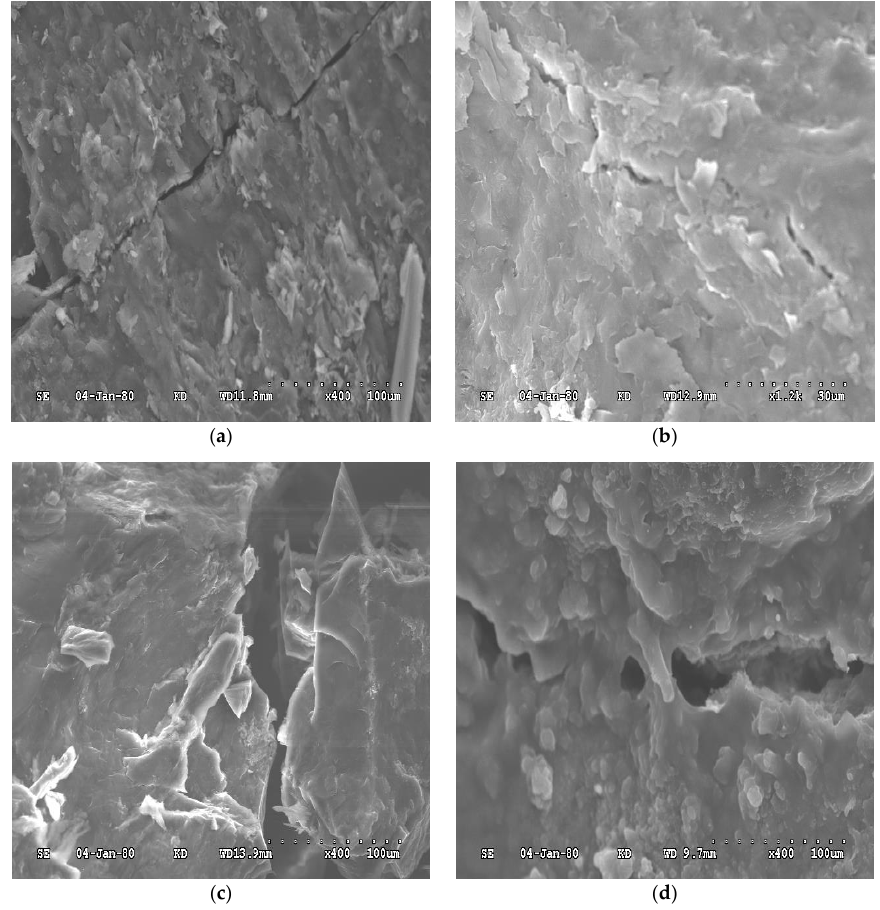
Figure 8. SEM image of the internal cracks structure: ( a ) before soaking; ( b ) soaking for 5 days; ( c ) soaking for 10 days and ( d ) soaking for 15 days.